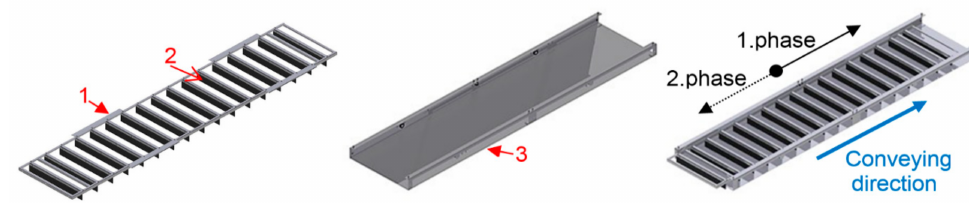
Figure 1. Special scraper conveyor without electric drive: 1—moveable frame, 2—scraping mem- branes and 3—basic static